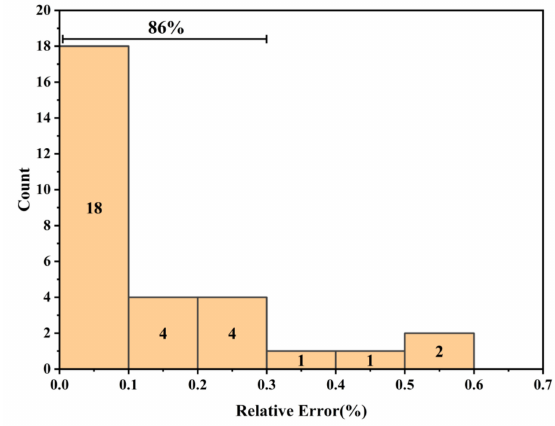
Figure 5. Error distribution of experimental test